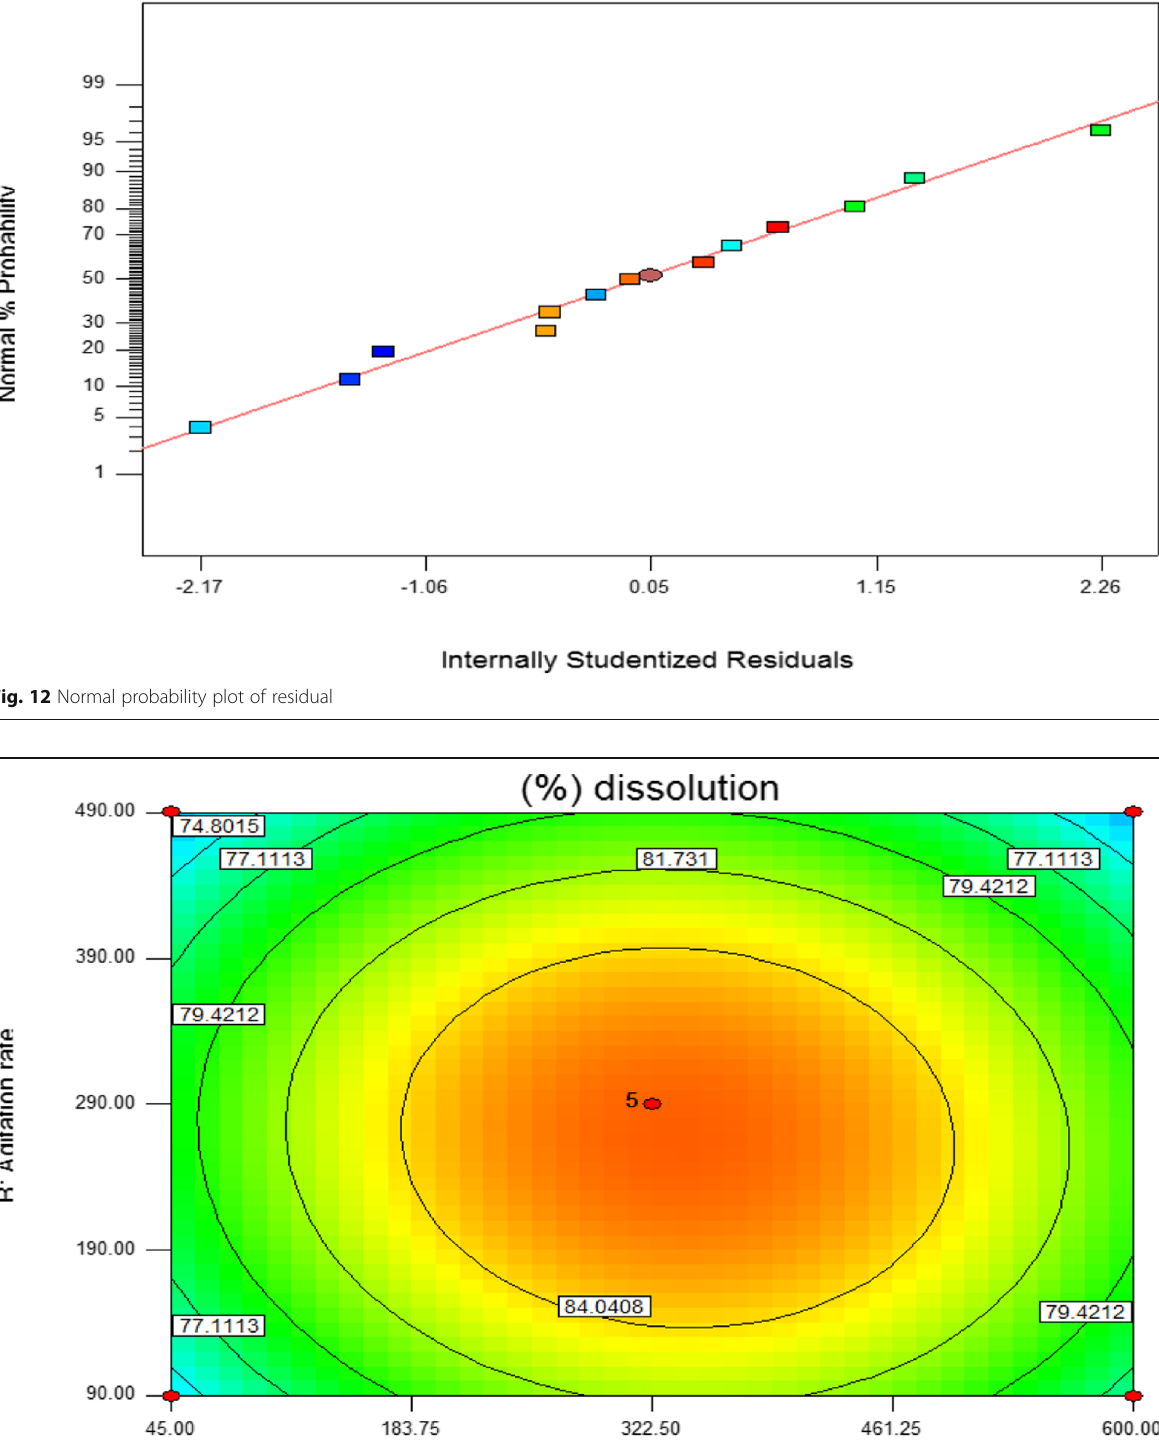
Fig. 13 Interactive 2D contour response surface plot for ore particle size and agitation